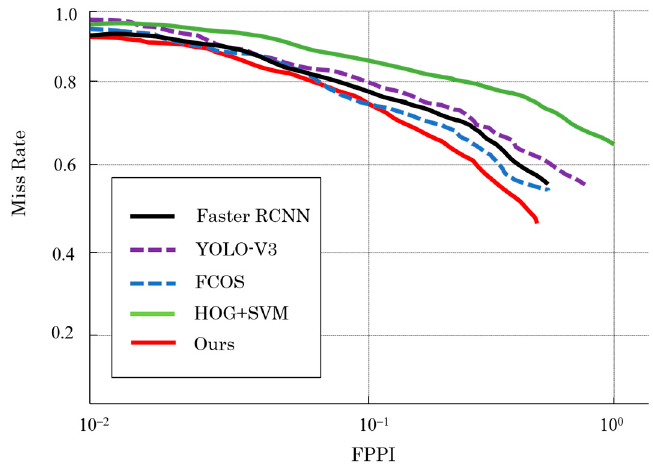
Figure 10. FPPI-MR Figure 10. FPPI-MR curve.